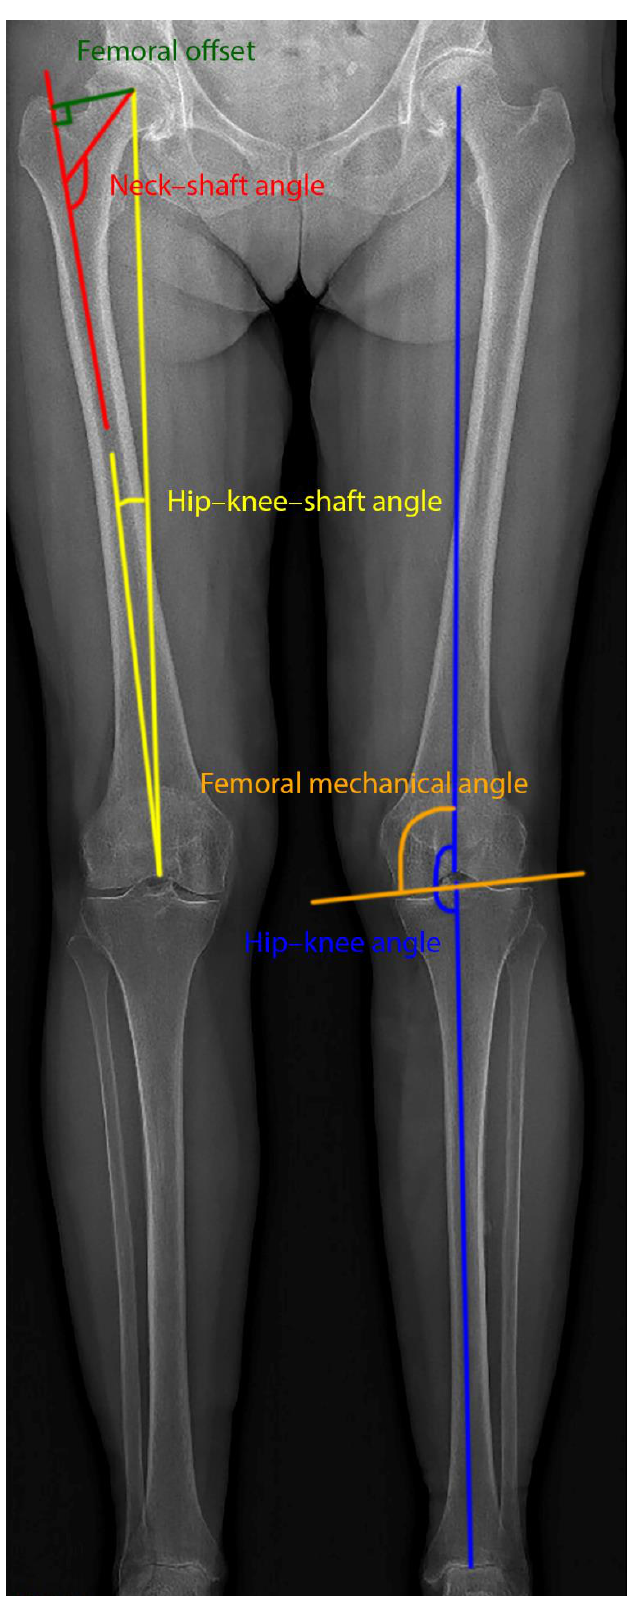
Figure 1. Clinical leg parameters overlaid on the frontal EOS image.